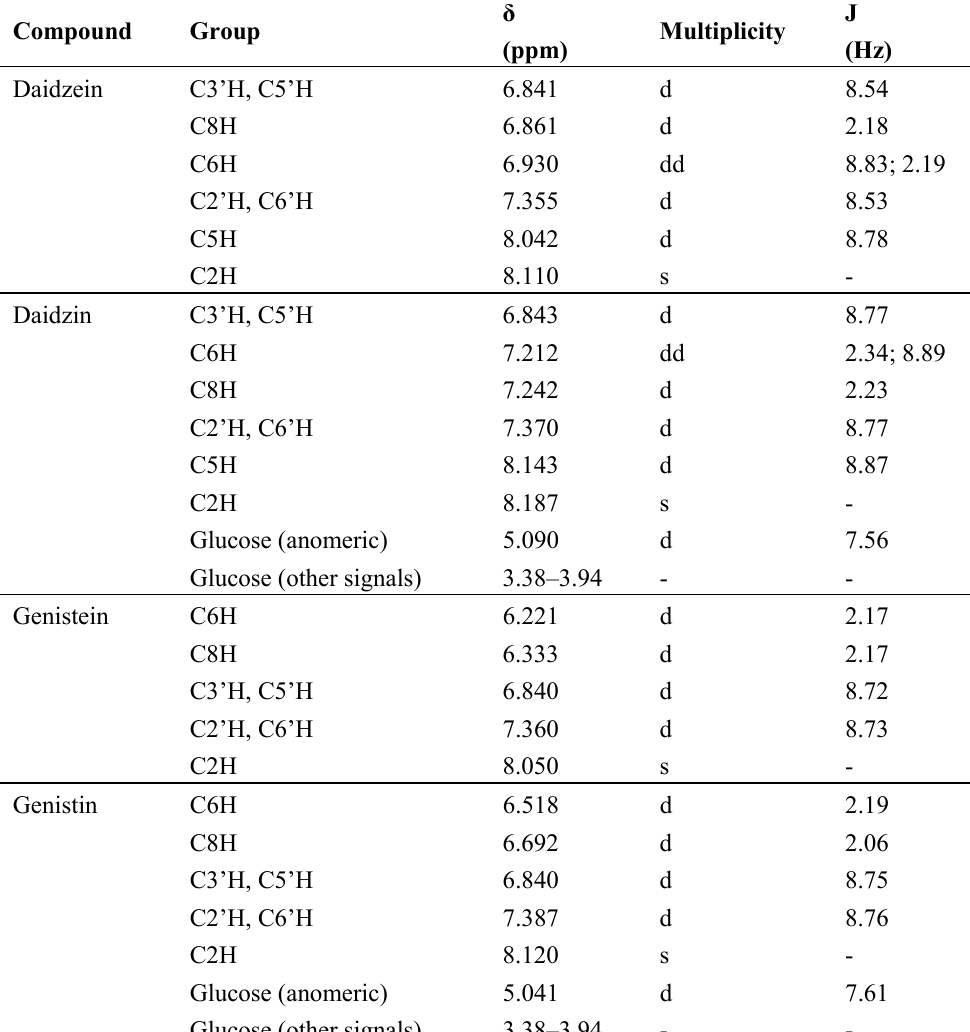
Table 2. Assignment of isoflavones standard compounds.